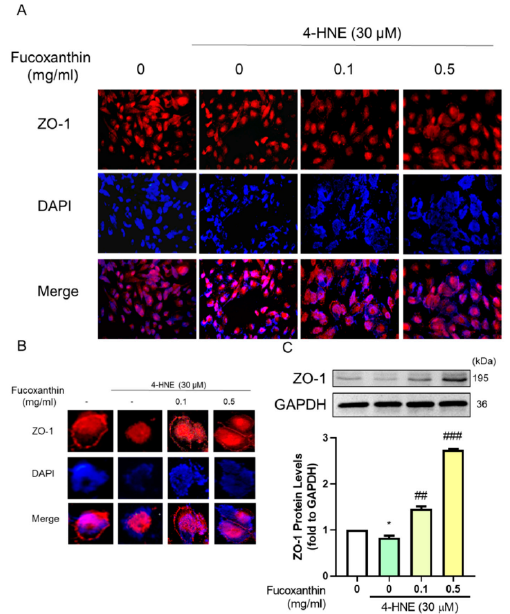
Figure 5. E ff ects of fucoxanthin on 4-HNE-induced ARPE19 tight junction-related protein expression. ARPE19 cells were cultured in DMEM F12 for 24 h after serum free starvation for 18 h. This was combined with fucoxanthin induced by 30 µ M 4-hydroxynonenal (4-HNE) for 24 h. We used ( A ) immunofluorescences, ( B ) the single cell structure completeness change, and ( C ) Western blotting to analyze the ZO-1 protein expression ( n = 4). *, p < 0.05 compared with the non-treated group. ##, p < 0.01; and ###, p < 0.001 compared with the induced group (4-HNE 30 µ M). We used a microscope at 40 × magnification.